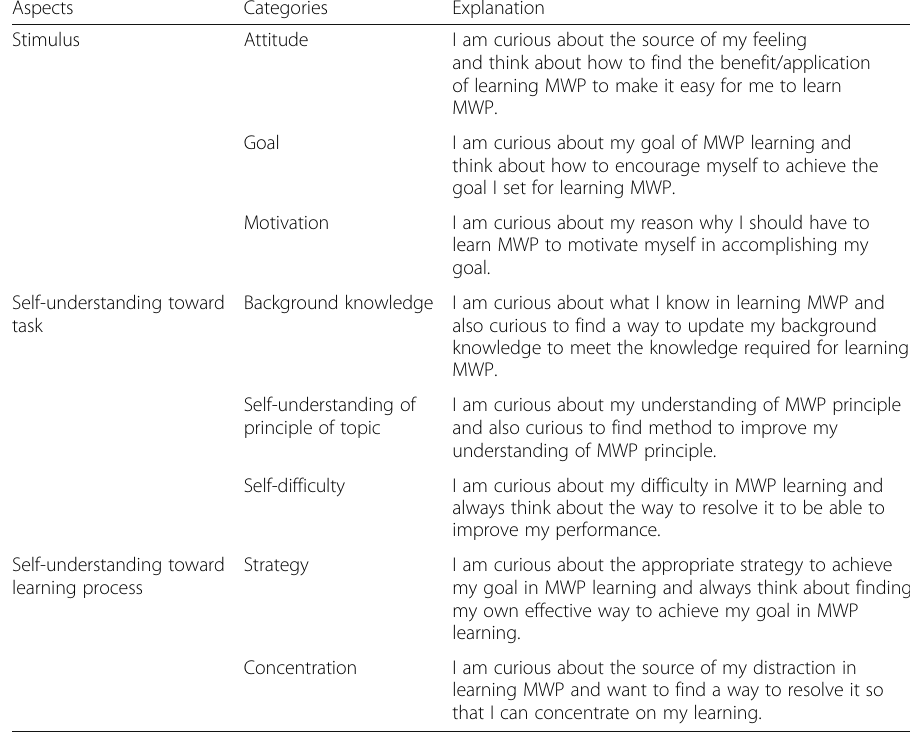
Table 1 Required skills of self-regulated learners in MWP learning for this dissertation